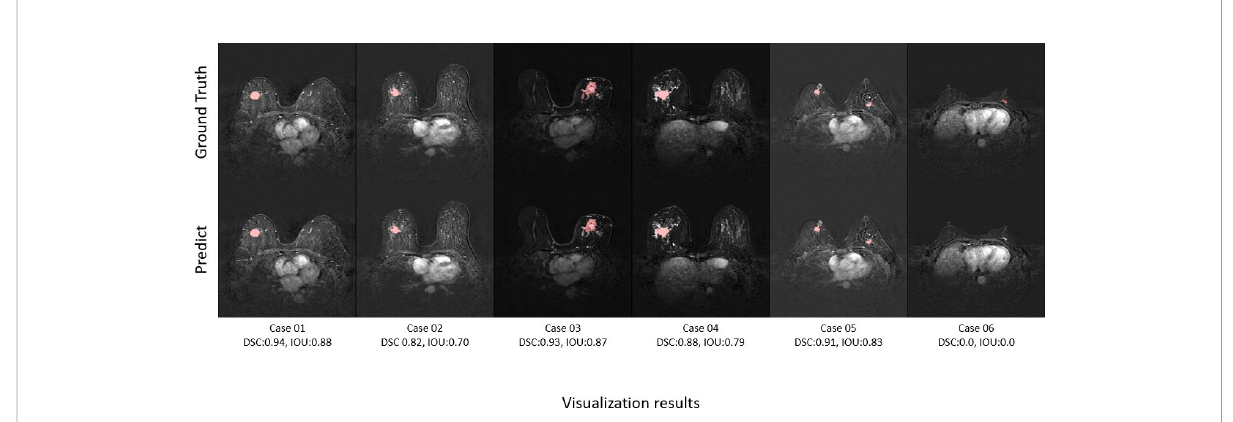
FIGURE 8 Six cases showing comparisons between the ground truth and our predicted results.